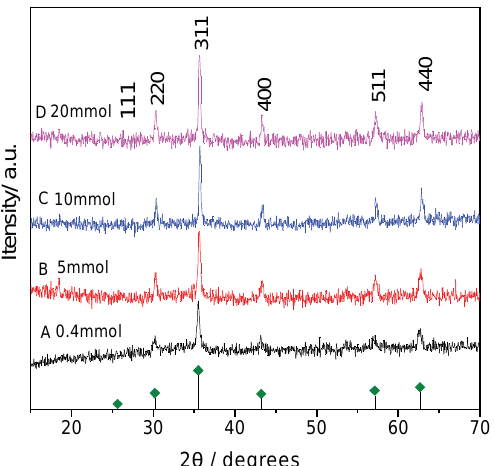
Figure 3. XRD patterns of Fe 3 O 4 obtained with different molar ratio of FeCl 3 ·6H 2 O, A: 0.4 mmol, B: 5 mmol, C: 10 mmol, D: 20 mmol.